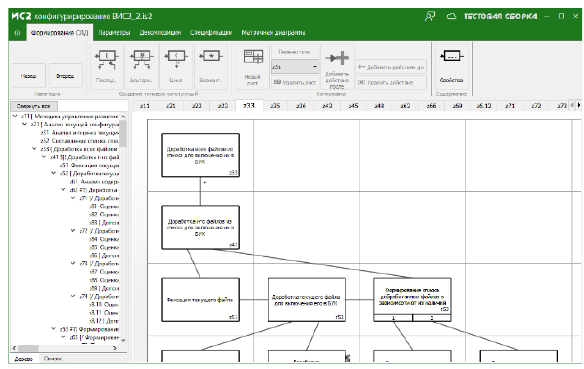
Fig. 4. Graphical interface of "IS-2": module for forming a system of subject actions